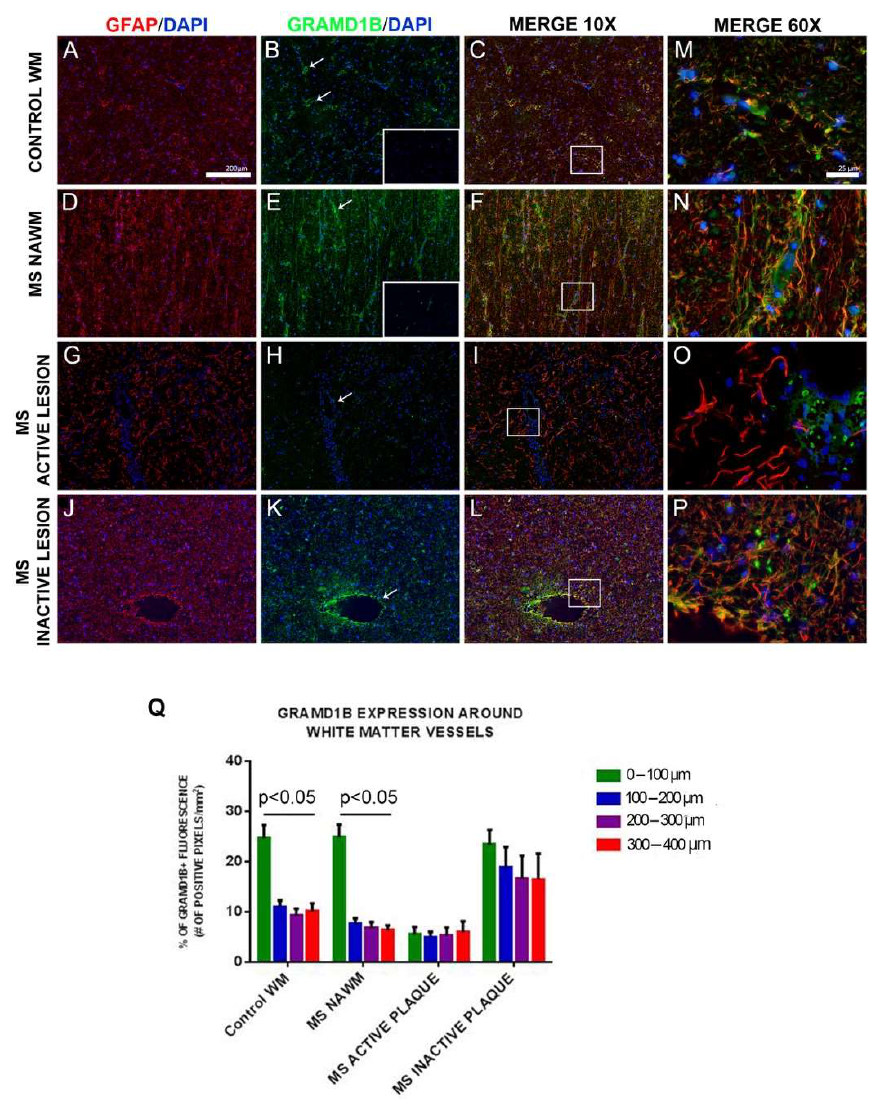
Figure 6. GRAMD1B expression in astrocytes of human brain tissues from MS and control subjects. Histological analysis of GRAMD1B protein expression on astrocytes in brain autopsied tissues of MS subjects and control subjects without evidence of CNS pathology. GRAMD1B expression is shown in green, and the GFAP astrocyte marker is in red. ( A – C ) Control subject, normal white matter (NWM). ( D – F ) MS patient, normal-appearing white matter (NAWM). ( G – I ) MS patient, active lesion site. ( J – L ) MS patient, inactive lesion site (10 × magnification). ( M – P ) Higher (60 × ) magnification of boxed areas shown in the “Merge 10 × column”. Isotype controls are represented in boxed areas of B and E pictures. ( Q ) Quantification of GRAMD1B expression at increasing distances from blood vessels (0–400 µ M) in normal white matter (control WM), in MS normal-appearing white matter (MS NAWM), in an active lesion of an MS patient (MS active plaque), and in an MS inactive lesion. Distance from blood vessels: green color: 0–100 µ m; blue color: 100–200 µ m; pink color: 200–300 µ m; red color: 300–400 µ m. Arrows in boxes ( B , E , H , K ) indicate GRAMD1B expression in astrocytes on blood vessels. Error bars represent the SEM. p value refers to the comparison of GRAMD1B expression at different distances from blood vessel in each tissue/lesion type (by Kruskal–Wallis test). We concluded that GRAMD1B was expressed in microglia and neurons as well as in astrocytes in human brain tissues of controls and MS